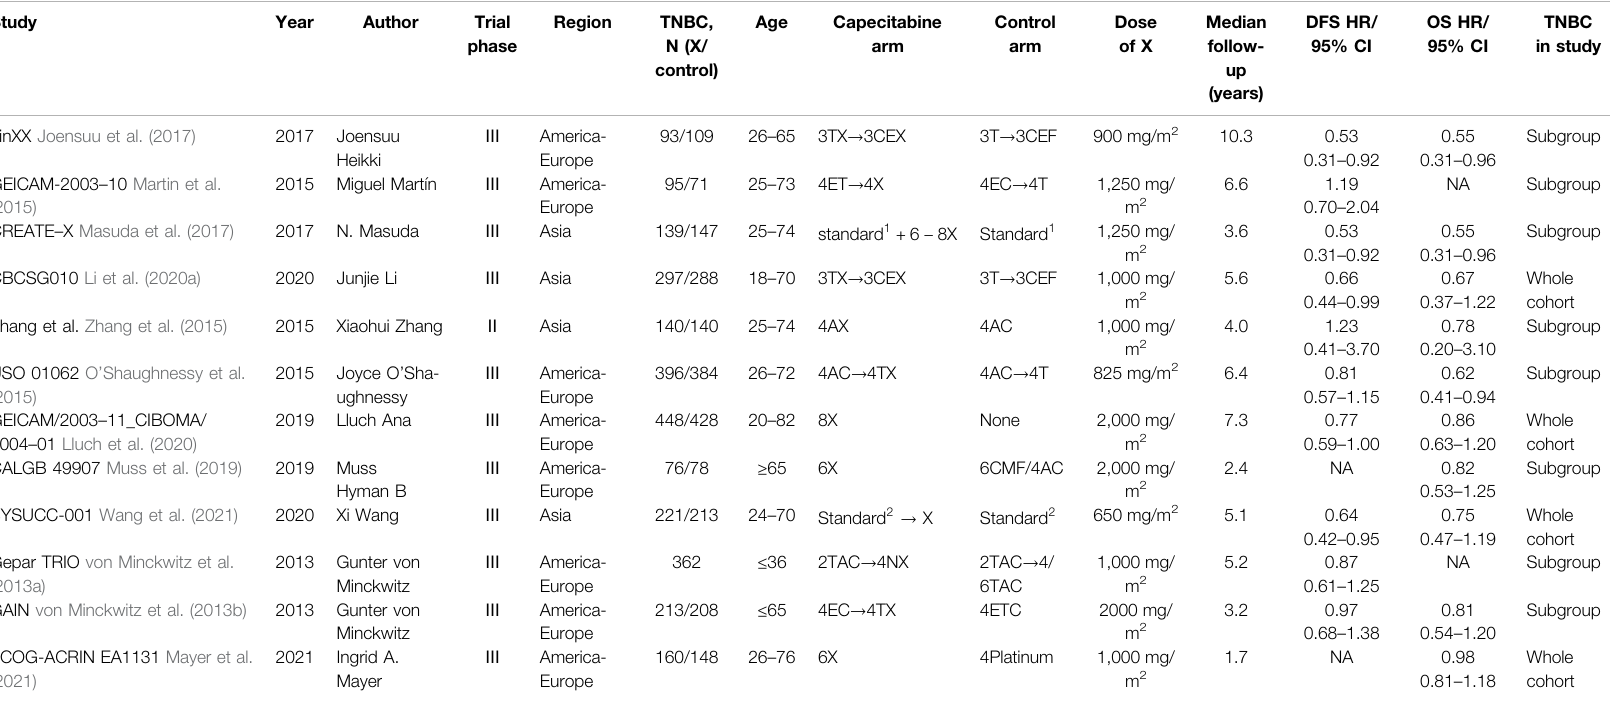
TABLE 1 | Characteristics of the included